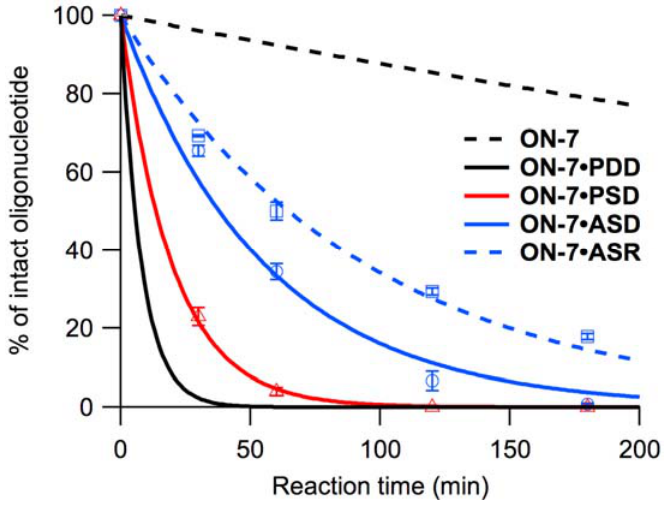
Figure 4. Cleavage profiles of ON-7 , with no template (black, dashed), PDD (black, solid), PSD (red, solid), ASD (blue, solid), and ASR (blue, dashed) at pH 4.0, 40 °C. Black lines are drawn using the kinetic parameters given in Table